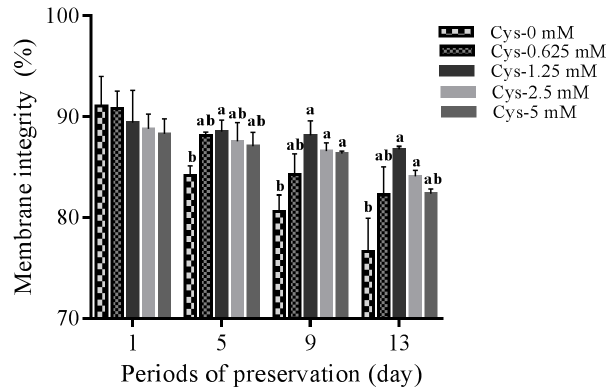
Figure 1. Dynamic changes in the sperm membrane integrity by ad- dition of different concentrations of cysteine to the diluted medium after 13 days’ preservation. Values are specified as mean±standard deviation (SD). a,b Columns with different lowercase letters differ sig- nificantly